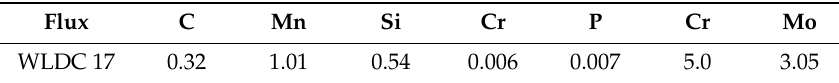
Table 3. Chemical composition of the flux